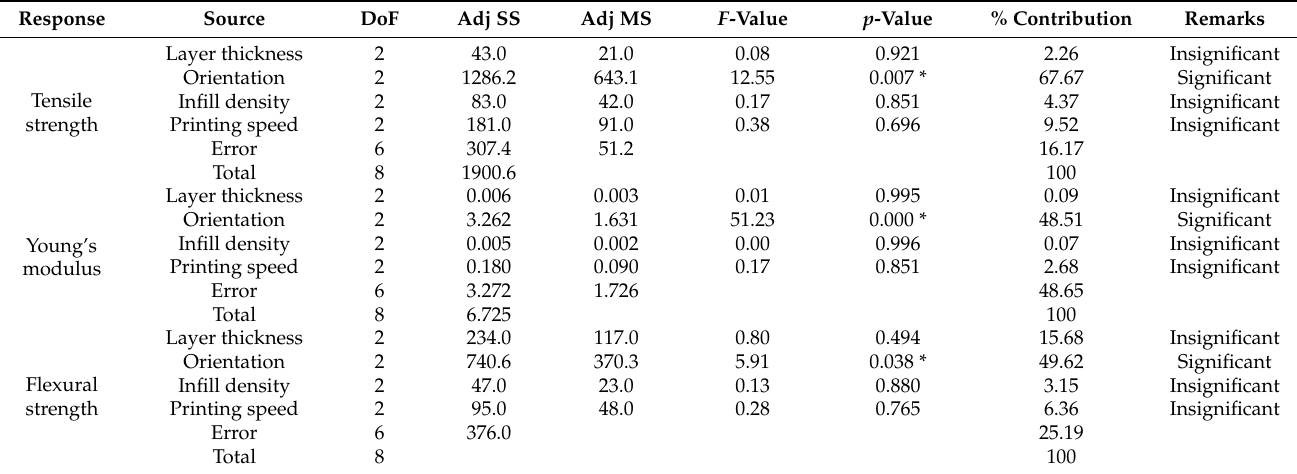
Table 4. ANOVA for each